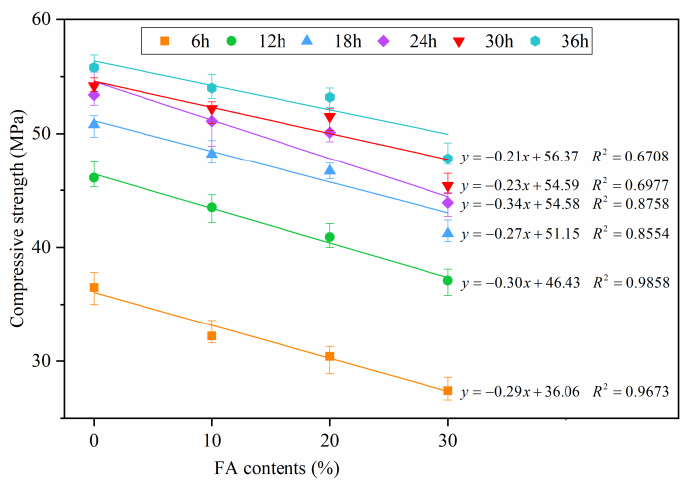
Figure 6. Relationship between FA concrete compressive strength and FA content.